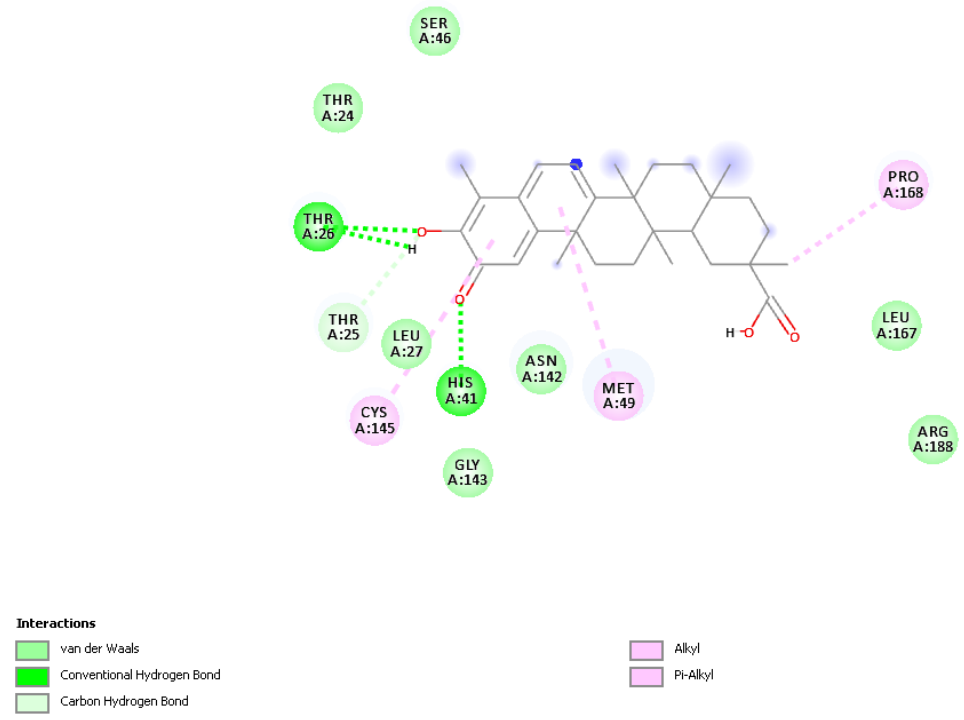
Figure 16. 2D display of Celastrol pose 5 after dynamic cascade.